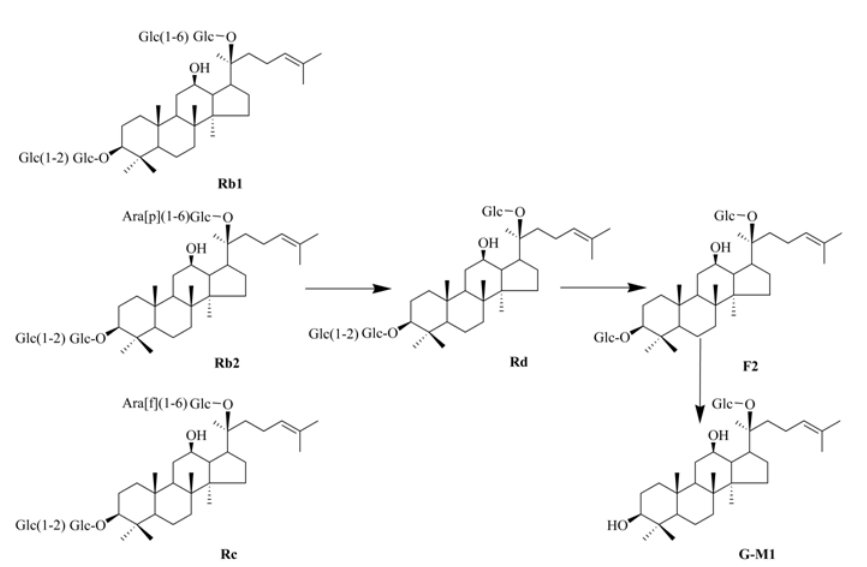
Figure 1. Proposed bioconversion pathway of PDG to